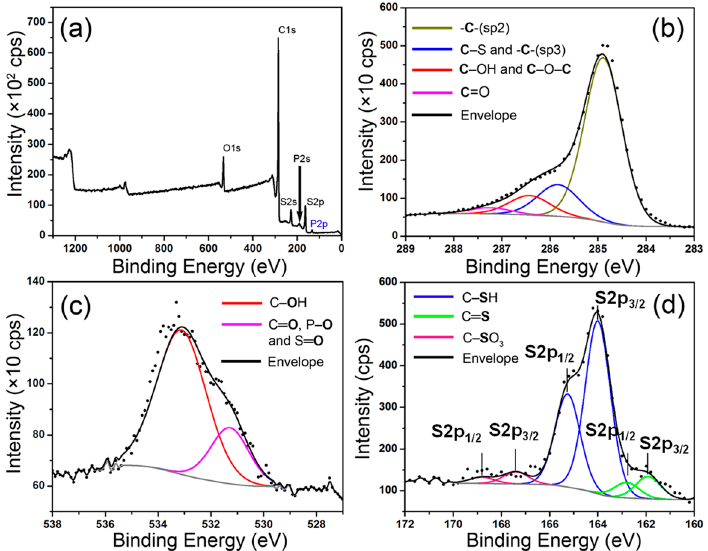
Figure 2. XPS spectra of mRGO-180: ( a ) wide scan; ( b ) high-resolution C1s; ( c ) high-resolution O1s and ( d ) high-resolution S2p. and ( d ) high-resolution